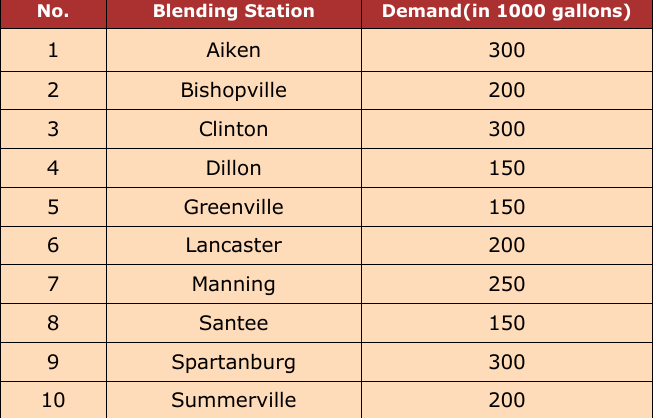
Table 1a. Demand for Blending